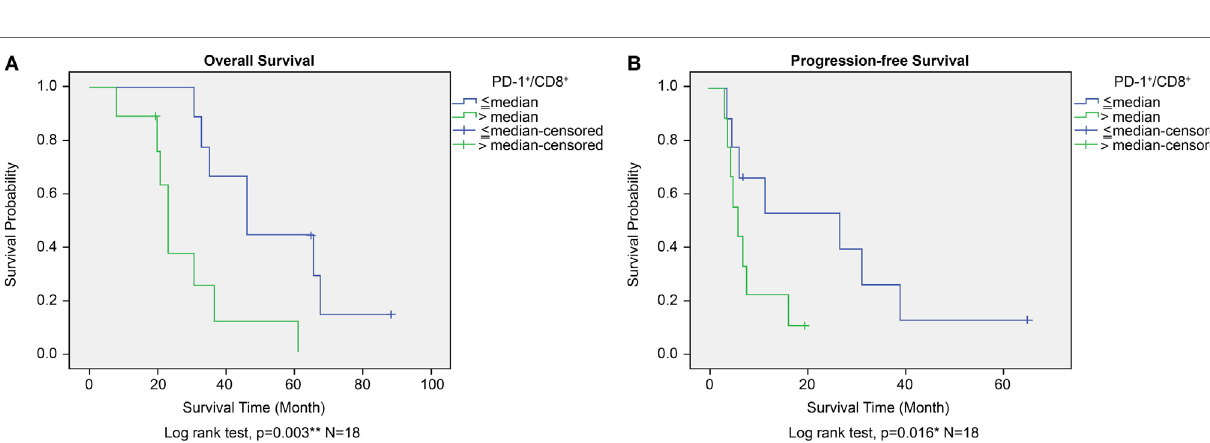
FigUre 7 | Correlation between tumor-infiltrating lymphocytes and peripheral blood mononuclear cells (PBMCs) in the ADCTA group. Pearson’s correlation between tumor-infiltrating lymphocytes and PBMCs from ADCTA patients (18 patients).